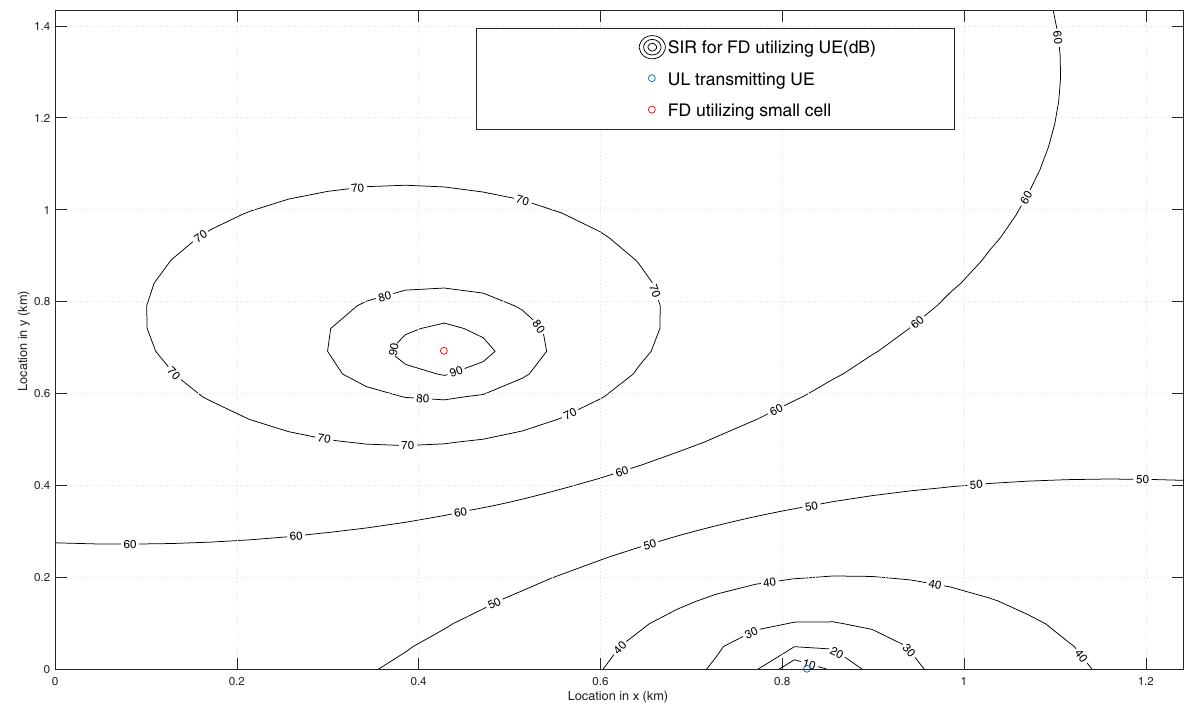
Fig. 11 Calculated signal-to-interference ratio at MT RX in case of nearby single UL transmission